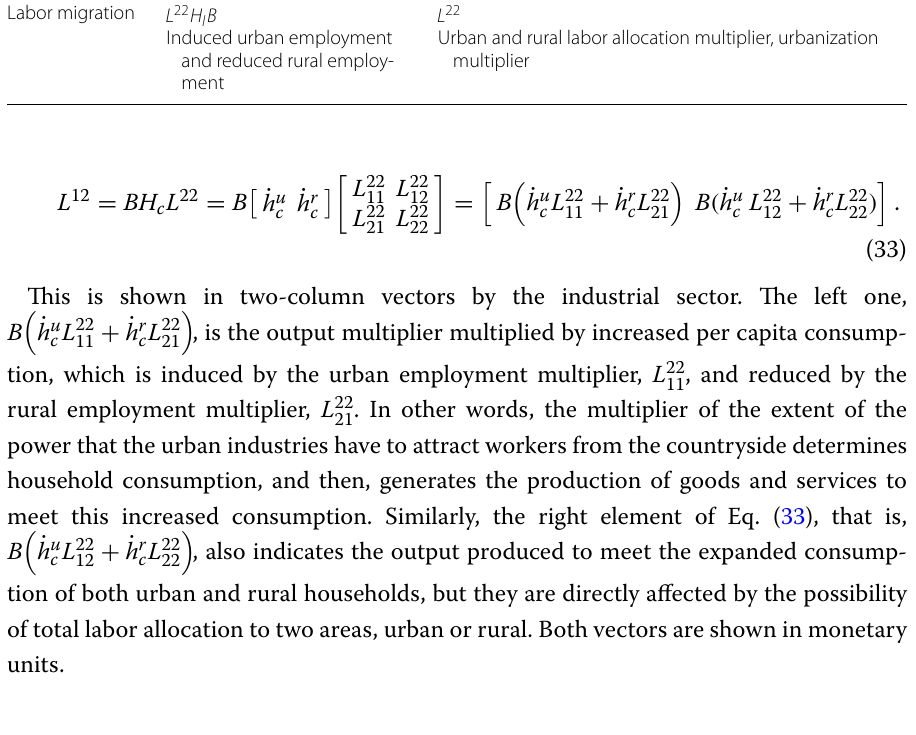
Table 3 Image of inverse matrix of extended input–output model for urbanization Industry Labor allocation (multiplier, probability)